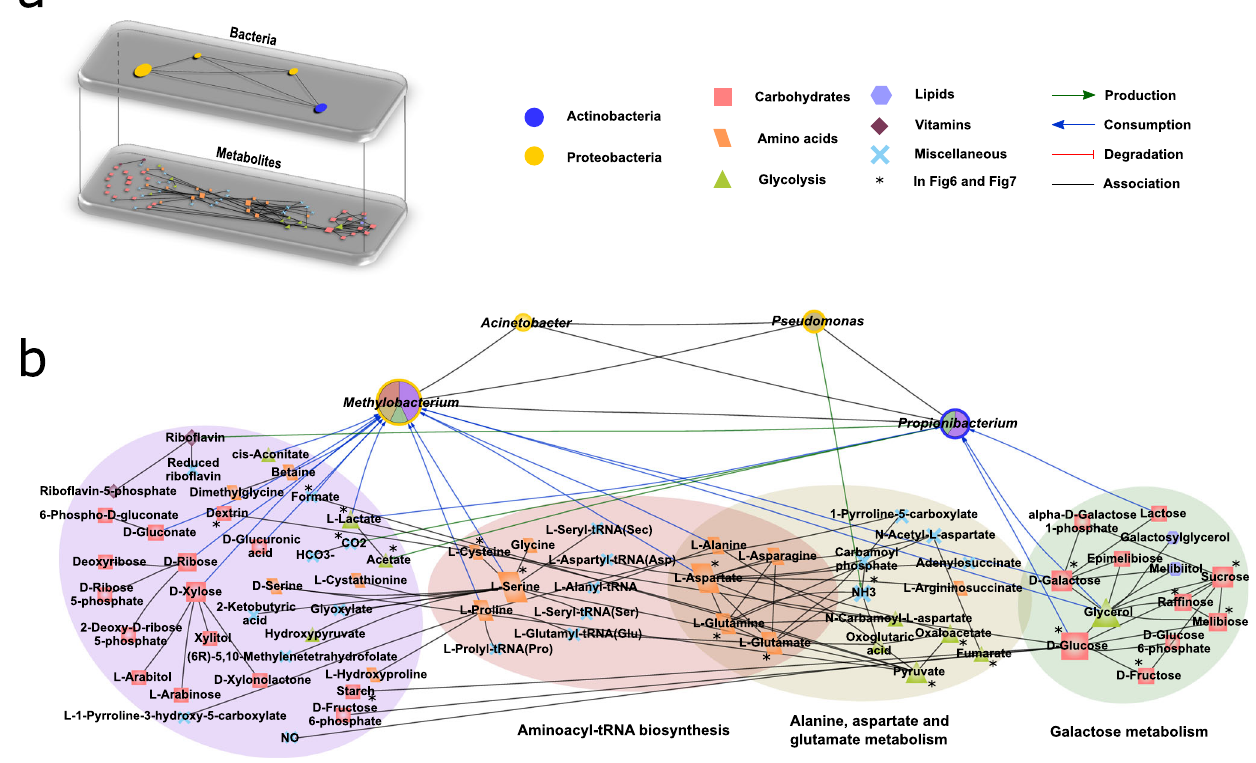
Fig. 7 H. pylori -affected bacteria-metabolite network in gastric environment of dyspeptic patients. a Multilayer (bacteria-metabolite) network representation: the fi rst layer is derived from Fig. 5 and represents the consensus network (con fi rmed in two different datasets of gastric mucosa: Paroni Sterbini et al. 22 and Parsons et al. 29 ) with H. pylori -affected bacteria nodes that present information on metabolite interaction in ref. 148 . The second layer represents the network whose nodes are the metabolites in ref. 148 interacting with the bacteria network in the fi rst layer; different node shapes and colours refer to different metabolite classes (carbohydrates, amino acids, glycolysis, lipids, vitamins, miscellaneous). b In depth visualization of the bacteria- metabolite network interactions. The metabolites are grouped according to their involvement in signi fi cant pathways. For discernibility, the metabolites are arranged according to three signi fi cant pathways ( p < 0.05 after Benjamini correction as result of a metabolite pathway enrichment analysis by a one-sided test) and a fourth group that encloses altogether nodes associated to other signi fi cant pathways (please refer to the method section: Bacteria-metabolite multilayer network construction and metabolite pathway analysis); note that only metabolites present in signi fi cant pathways are here displayed. For more information, please refer to Supplementary Fig. 18 and Supplementary Data 7. The bacteria node stroke color is associated to the phyla information as in Fig. 5, whereas the different colours in the inner fi ll are associated to the different pathways and their extent is proportional to the number of metabolites that the bacterium connects with in the different displayed